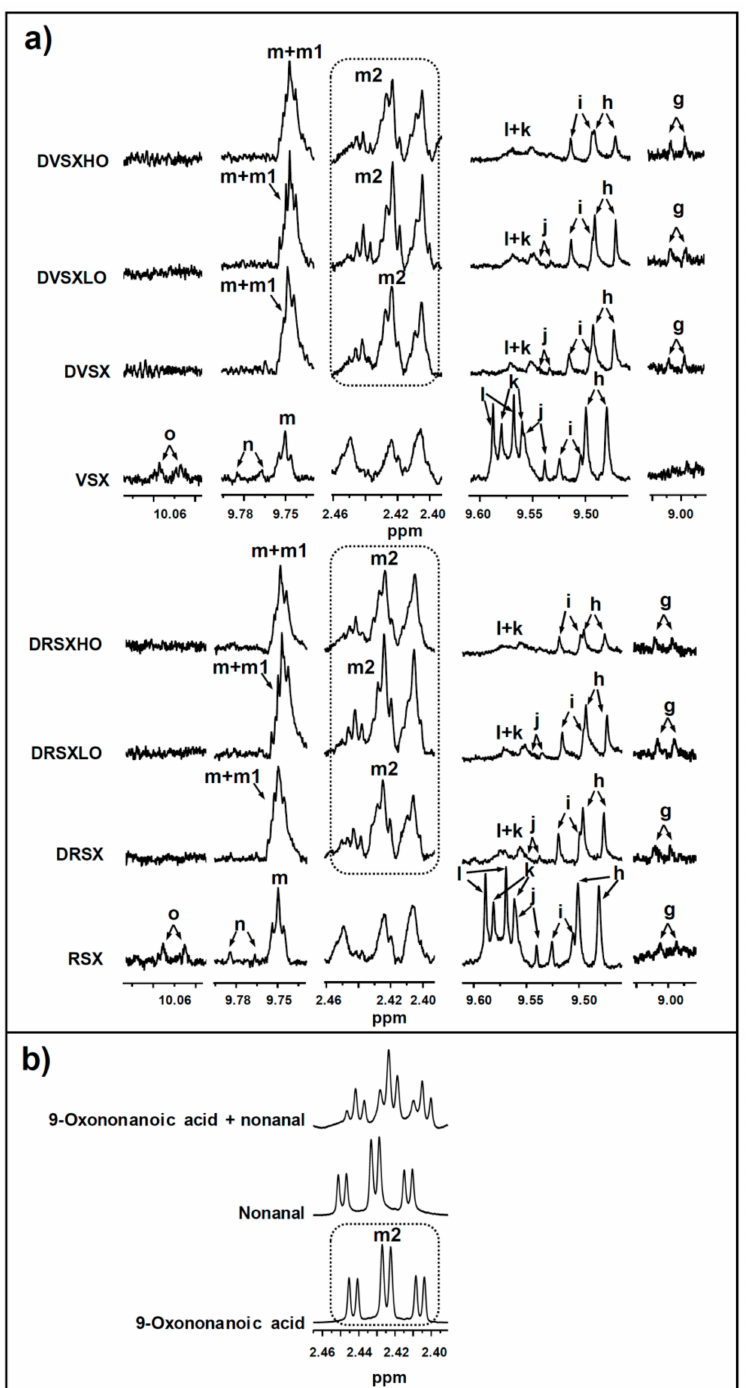
Figure 3. Enlargements of: ( a ) some regions of aldehydic signals of the 1 H NMR spectra of the highly oxidized virgin and refined soybean oils (VSX and RSX), and of the lipid extracts obtained after their in vitro digestion in the absence of ovalbumin (DVSX and DRSX), as well as in the presence of a low (DVSXLO and DRSXLO) and a high proportion of ovalbumin (DVSXHO and DRSXHO); and ( b ) one of the 1 H NMR spectral regions where typical signals of 9-oxononanoic acid and of saturated aldehydes appear, corresponding to pure 9-oxononanoic acid, to nonanal and to a mixture of both. The signal letters agree with those in Table S6. The plots corresponding to the same 1 H NMR spectral region are presented at a fixed value of absolute intensity, for them to be valid for comparative